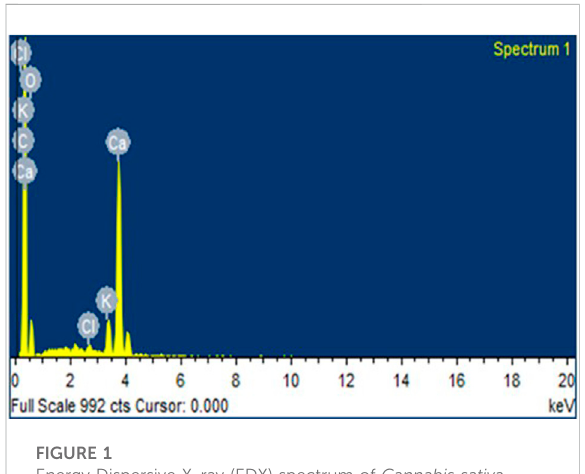
FIGURE 1 Energy Dispersive X-ray (EDX) spectrum of Cannabis sativa